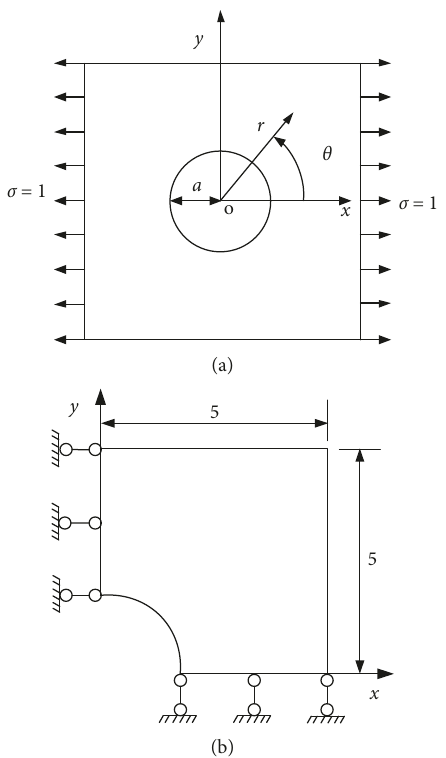
Figure 13: Infinite plate with circular hole and its quarter